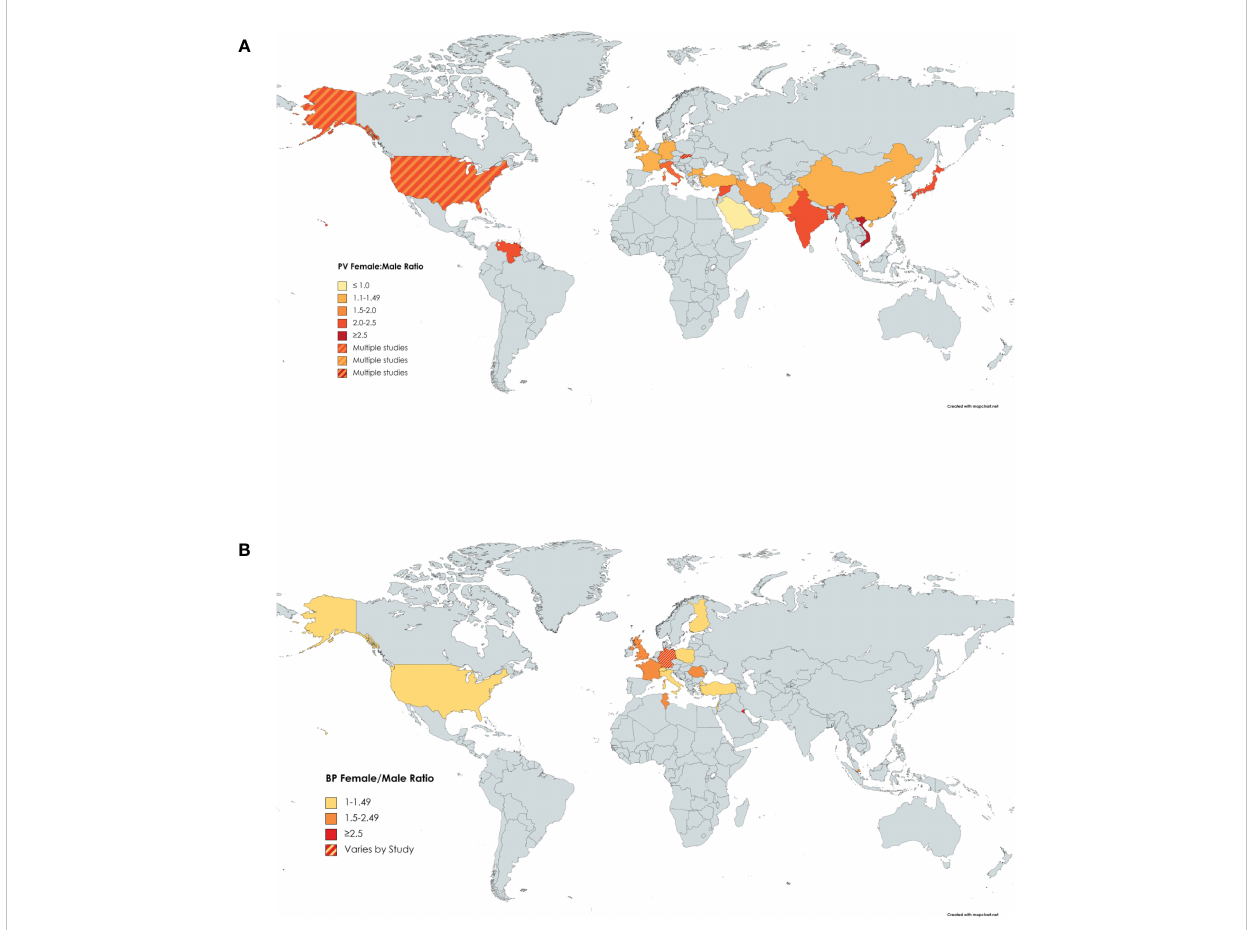
FIGURE 3 Gender Ratio of PV by Country. Darker shading signi fi es higher female:male gender ratio of (A) PV or (B) BP. Countries with more than one shaded color signify that more than one study had results that fell into different